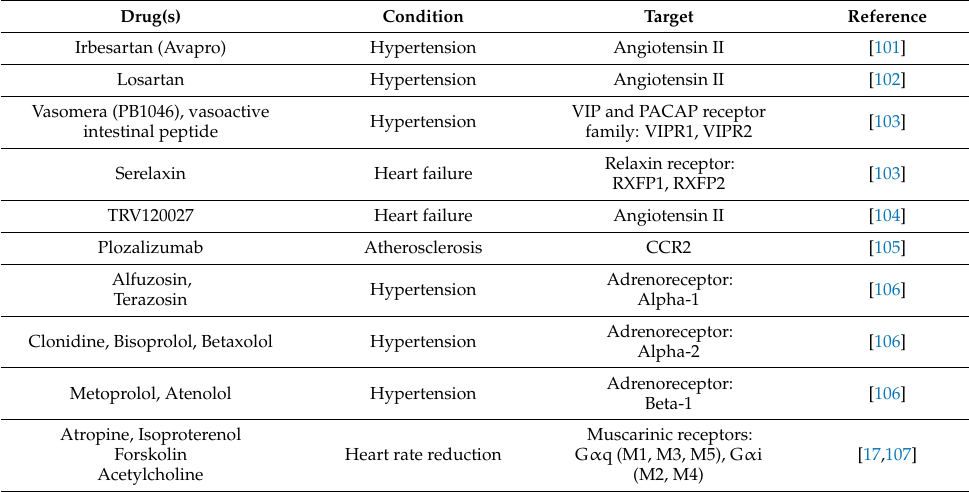
Table 2. GPCR-targeted drugs used for cardiovascular